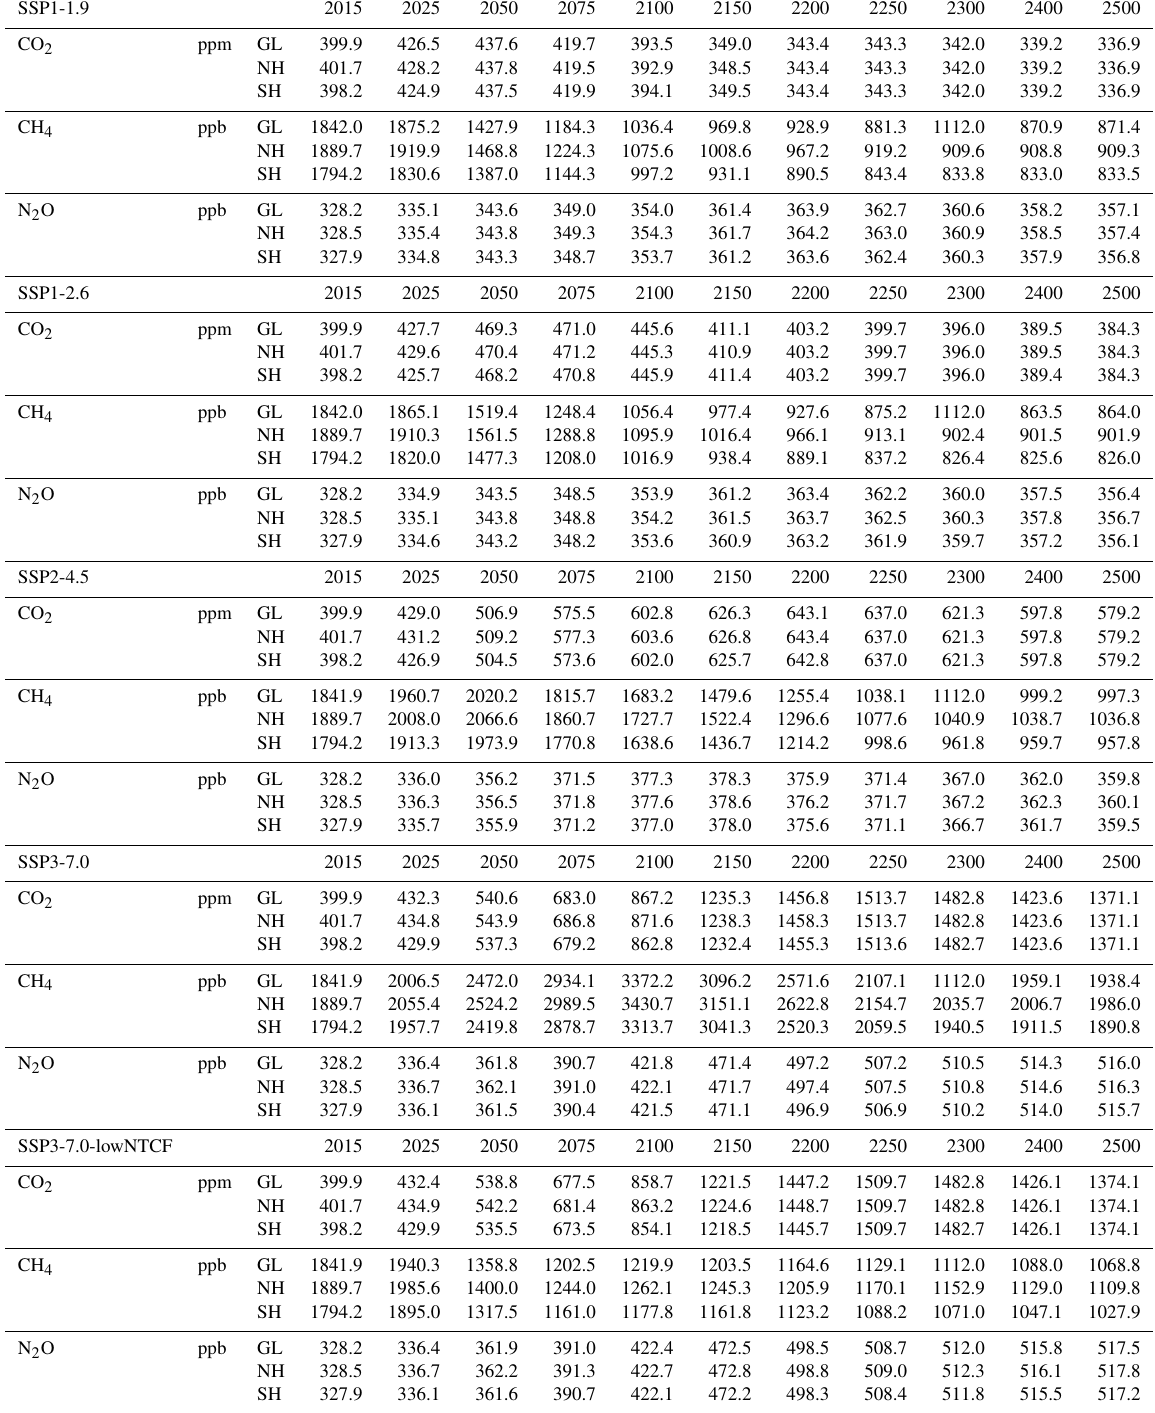
Table 5. Overview of CO 2 CH 4 and N 2 O concentrations in the eight SSP scenarios considered in this study with global-average (“GL”) northern hemispheric (“NH”) and southern hemispheric (“SH”) surface air mole fractions. For annual and latitudinally resolved mole frac- tions and other greenhouse gases see the Supplement or http://greenhousegases.science.unimelb.edu.au.